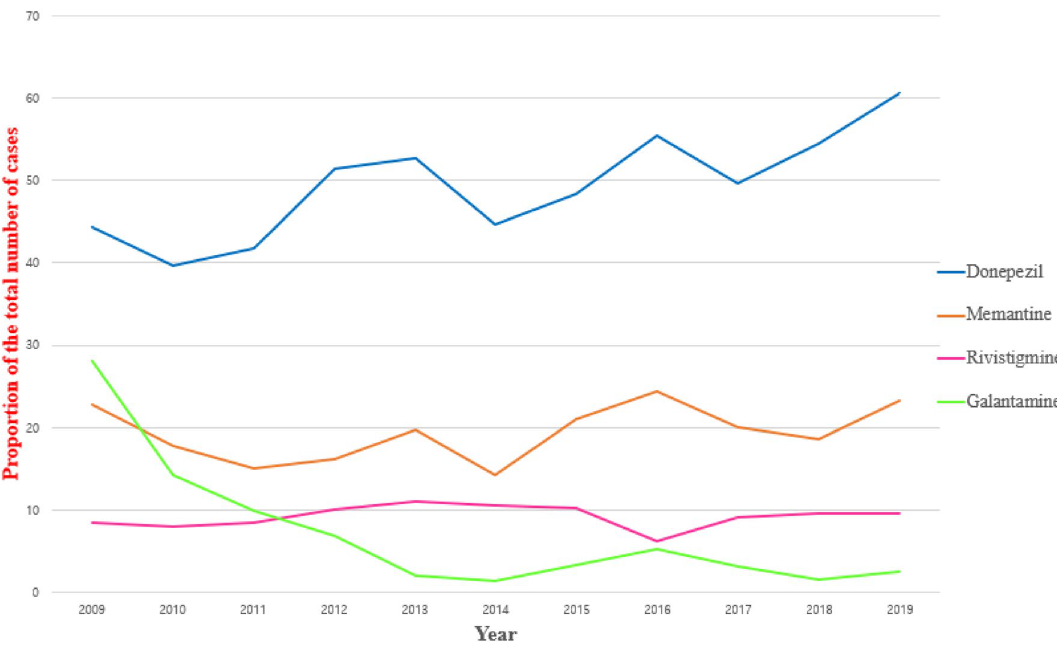
Figure 3. Trends for anti-dementia drug treatment of Alzheimer’s disease as broken line graphs. The horizontal axis represents the year and the vertical axis represents the proportion of the total number of